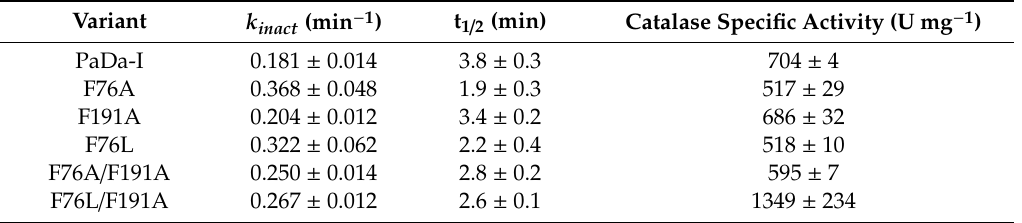
Table 2. Pseudo-first-order inactivation constants of PaDa-I and mutants F76A, F191A, F76L, F76A / F191A, and F76L / F191A when incubated in H 2 O 2 , and their catalase